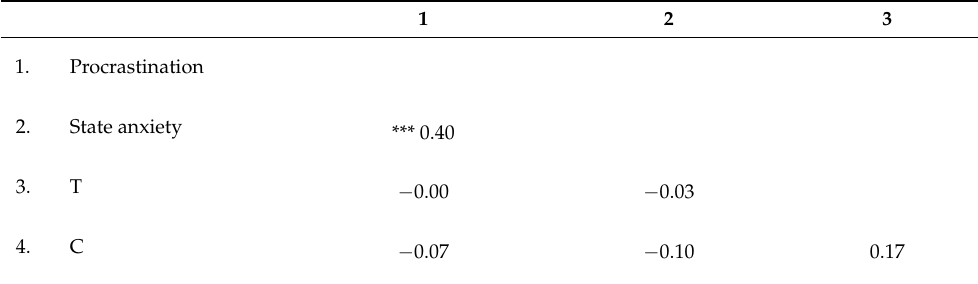
Table 2. Correlations between hormones, procrastination, and state anxiety.